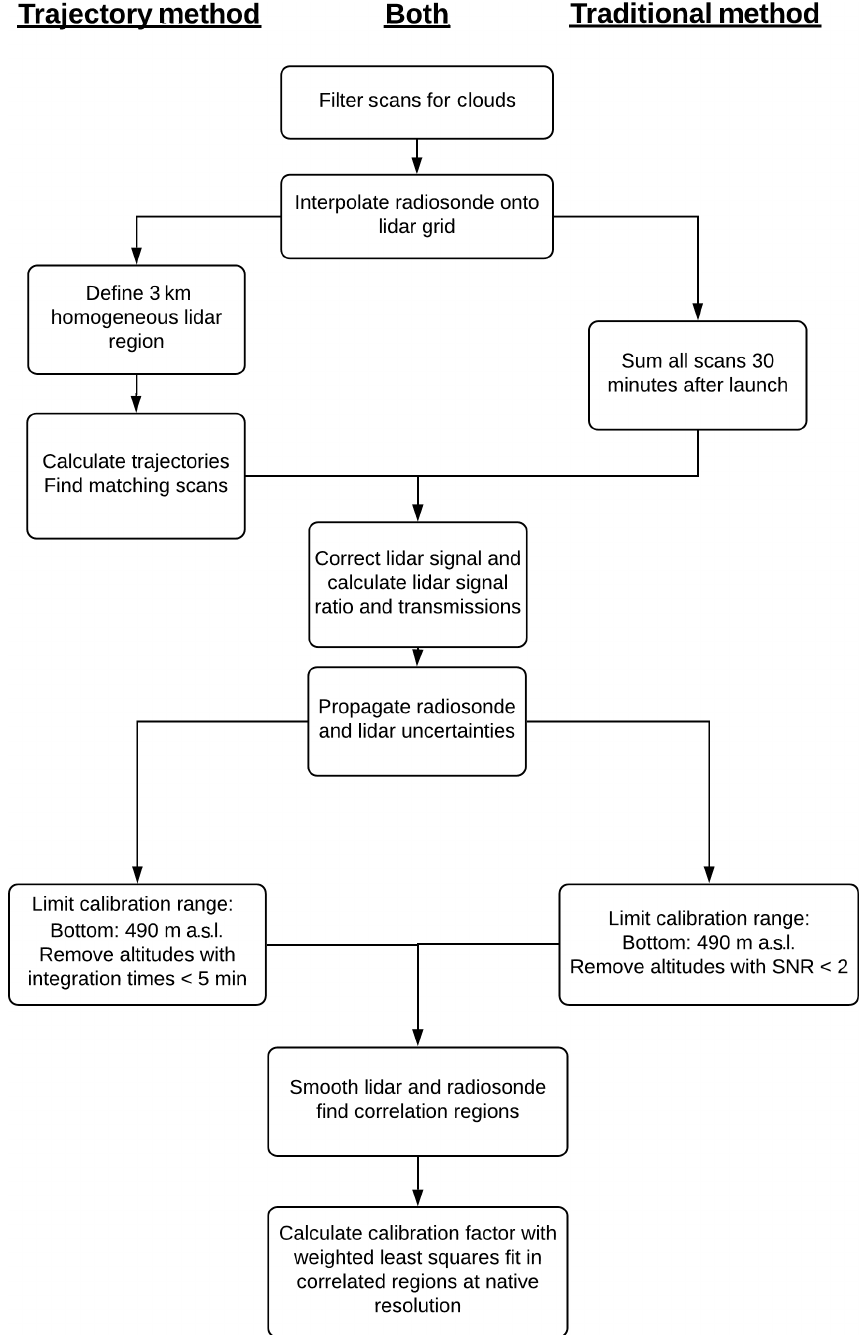
Figure 4. Flowchart of the steps to calibrate the RALMO lidar by the trajectory method (left) and the traditional method